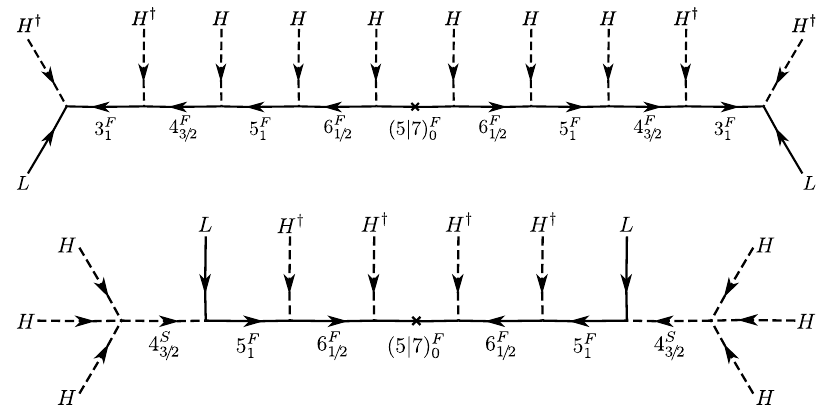
Figure 9 . The two genuine diagrams at d = 13 can be realized in a total of 6 models. It is possible to have either a 5 F or a 7 F in the middle. Furthermore, two extra models are obtained from the 0 0 top diagram by rearranging appropriately the external H ’s and H y ’s and replacing either one or both of the internal 4 F correspondingly by a 4 F . Note also that these two extra models (not 3 = 2 1 = 2 represented above) with the (cid:12)eld 4 F need 7 F in the middle of the diagram in order to be 0 1 = 2